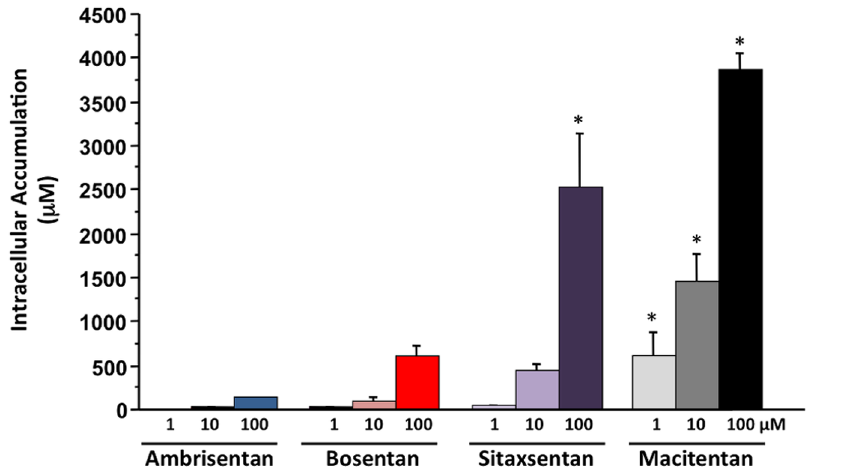
Figure 4. Dose-dependent intracellular accumulation of test ERAs in sandwich-cultured human hepatocytes. Ambrisentan displayed the lowest intracellular accumulation followed by bosentan, sitaxsentan, and macitentan. Data are presented as mean ( 6 SD) micromolar ( m M) concentration; n=3 donors; *P , 0.05 vs. corresponding intracellular accumulation value for ambrisentan at the same test concentration.